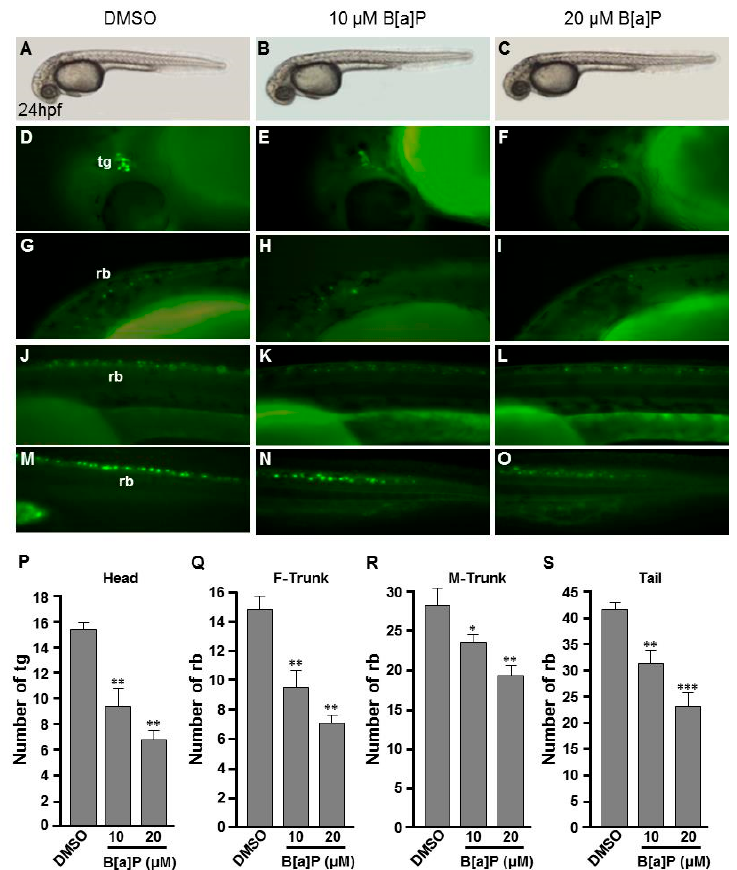
Figure 1. Developmental neurotoxicity of B[a]P revealed by the Tg(elavl3:EGFP) model. Tg(elavl3:EGFP) zebrafish embryos received the indicated treatments: 0 μ M. (control, 01% DMSO; ( A , C , F , I , L )), 10- μ M B[a]P ( B , D , G , J , M ) and 20- μ M B[a]P ( C , E , H , K , N ). ( A – C ) Lateral view of the live embryos at 24 hpf after treatment with 0.1% DMSO (control; A ), 10- μ M B[a]P ( B ) and 20- μ M B[a]P ( C ); ( D – O ) Effects of B[a]P on neurogenesis using the Tg(elavl3:EGFP) model. The embryos treated with 0.1% DMSO (control; ( D , G , J , M )), 10- μ M B[a]P ( E , H , K , N ) and 20- μ M B[a]P ( F , I , L , O ) were collected at 24 hpf. Representative fluorescent images are shown for embryonic trigeminal ganglions (tg) in the head region ( D – F ) and Rohon–Beard cell (rb) in the front trunk ( G – I ), mid-trunk ( J – L ) and in tail regions ( M – O ). ( P – S ) The numbers of tg cells in the head region and rb cells in front-trunk (F- trunk), mid-trunk (M-Trunk) and tail were counted from 10 embryos in each treatment group. Data are shown as mean ± standard deviation. * p < 0.05, ** p < 0.01, *** p < 0.001 compared with the control.